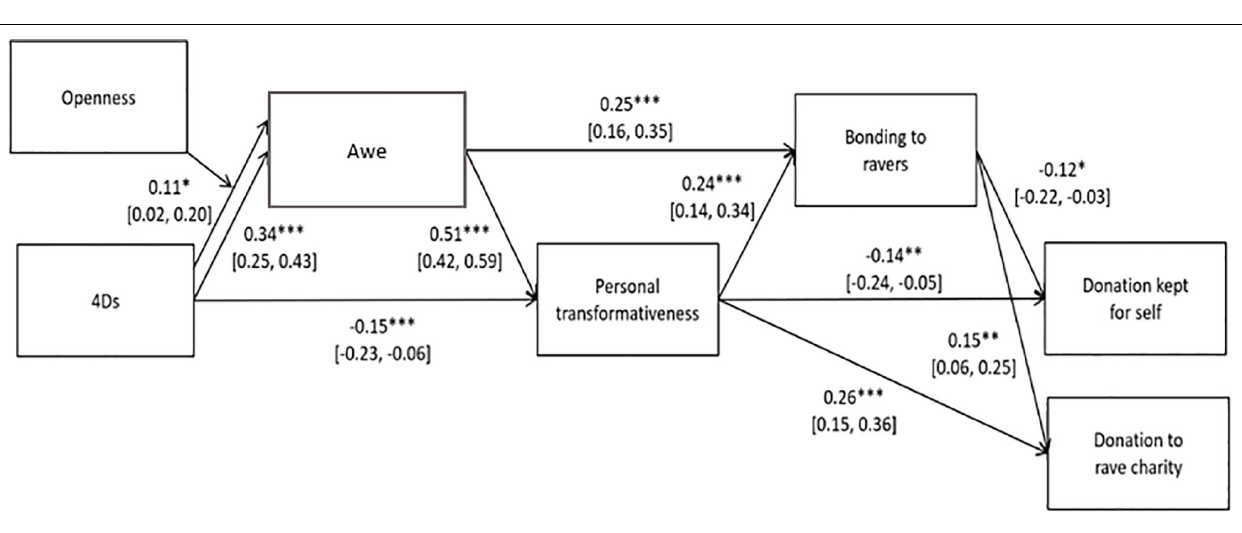
FIGURE 7 | Full structural equation model of the 4Ds at raves > awe > transformativeness > bonding > prosociality pathway. Standardized beta coefficients with 95% CIs. ∗ p < 0.05, ∗∗ p < 0.001, ∗∗∗ p <